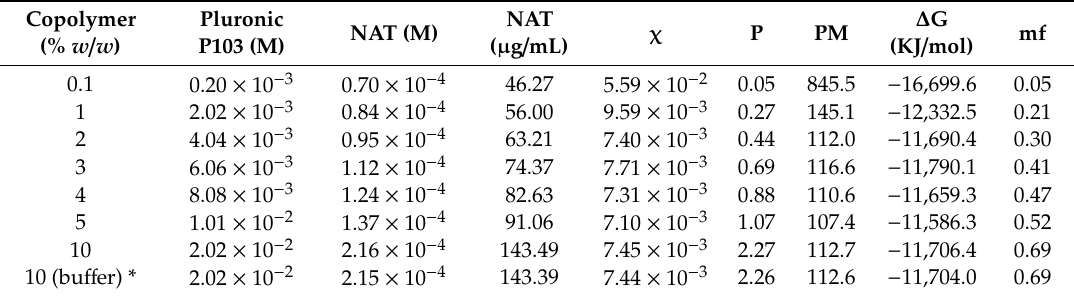
Table 3. Capability of Pluronic P103 dispersions in 0.9% NaCl to solubilize natamycin, estimated using Equations (1)–(5). (NAT: natamycin; χ : molar solubilization capacity; P: partition coe ffi cient; PM: molar partition coe ffi cient; ∆ G: standard-free Gibbs energy of solubilization; mf: molar fraction of drug encapsulated inside the micelle). * Data from solubility experiments carried out in pH 6.4 bu ff